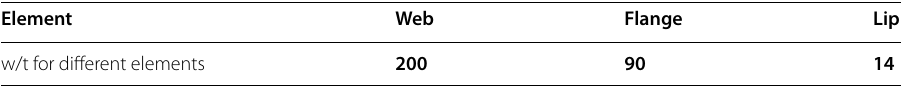
Table 2 Recommended width to thickness ratio (w/t) in AISI Element Web w/t for different elements